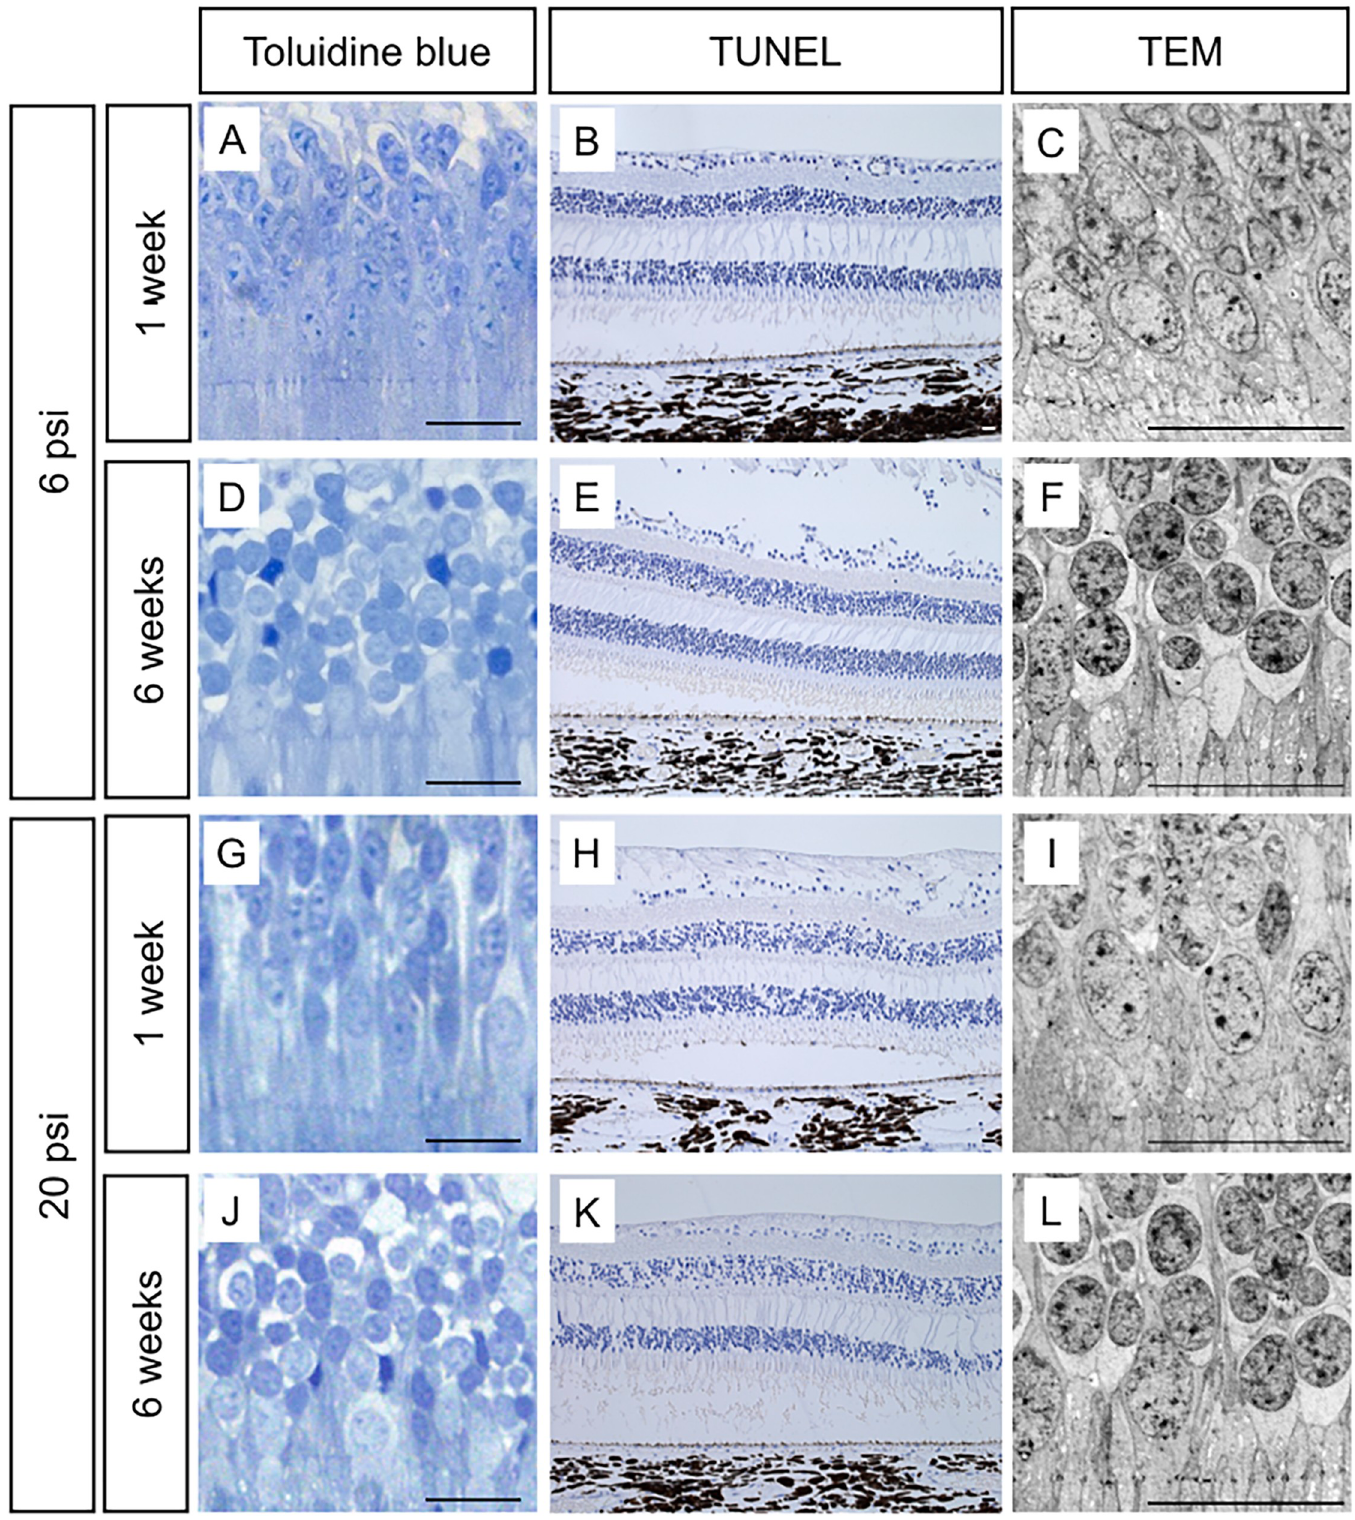
Fig 5. The effect of subretinal injection on photoreceptor cells. In the minimum-pressure (injection at 6 psi with balanced salt solution; BSS) and high-pressure (BSS injection at 20 psi) groups, both light microscopy images with toluidine blue staining and transmission electron microscopy (TEM) images show normal morphology of